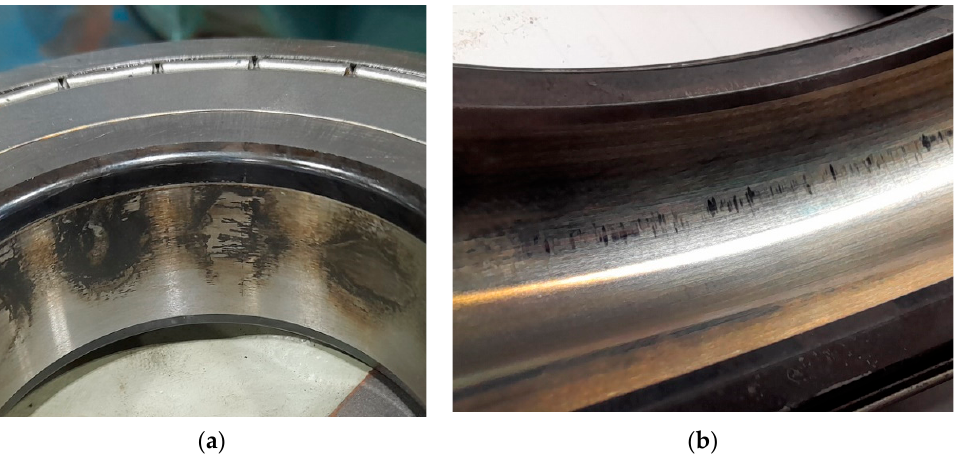
Figure 1. Irregular pitting of the bearing caused by the flow of bearing currents on the inner surface of the bearing ( a ) and the inner surface of the outer race of the bearing ( b ).